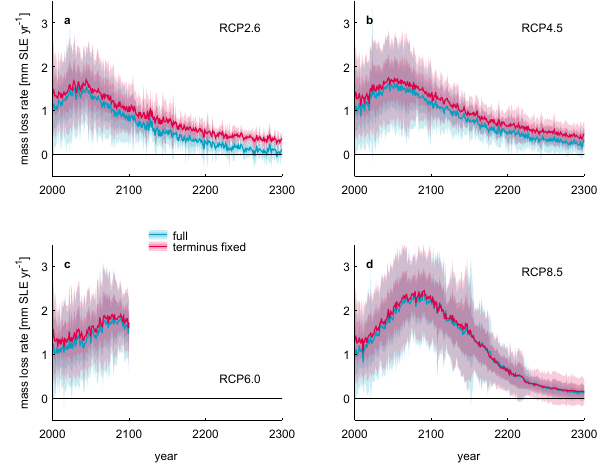
Fig. 9. Effect of fixed glacier terminus altitude on glacier mass change; “full” refers to the results of Marzeion et al. (2012) with fully responsive glacier hypsometry. Solid line is ensemble mean, dark/light shading indicates ensemble spread (one/two standard de- viations). Different panels refer to different RCPs.